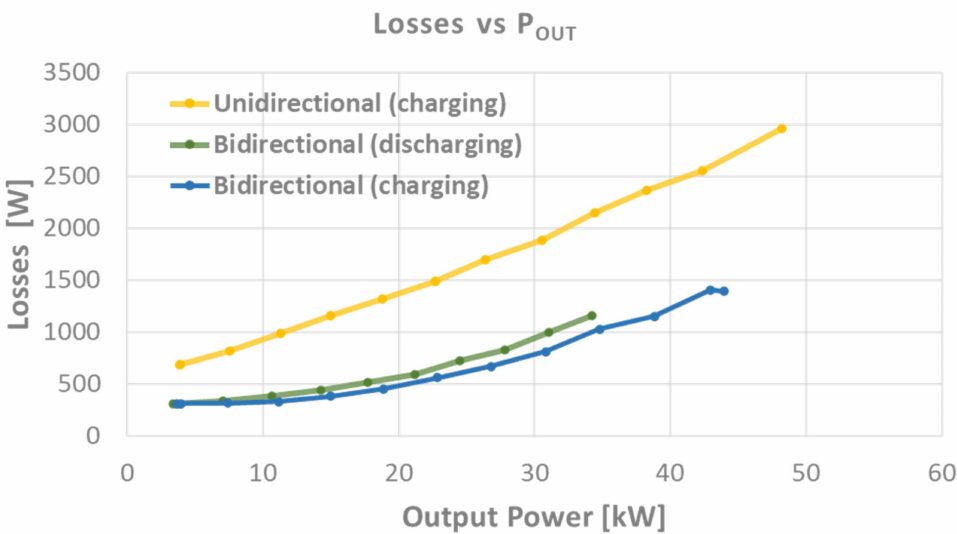
Figure 21. Power loss characteristics vs. output power (P OUT ) of the analyzed DCFC systems, from the top: power loss characteristic of the unidirectional charger with IGBT power transistors during charging mode (yellow), power loss characteristic of the bidirectional charger with SiC power transistors during discharging mode (dark green), power loss characteristic of the bidirectional charger with SiC power transistors during charging mode (dark blue). Battery voltage range of 360–410